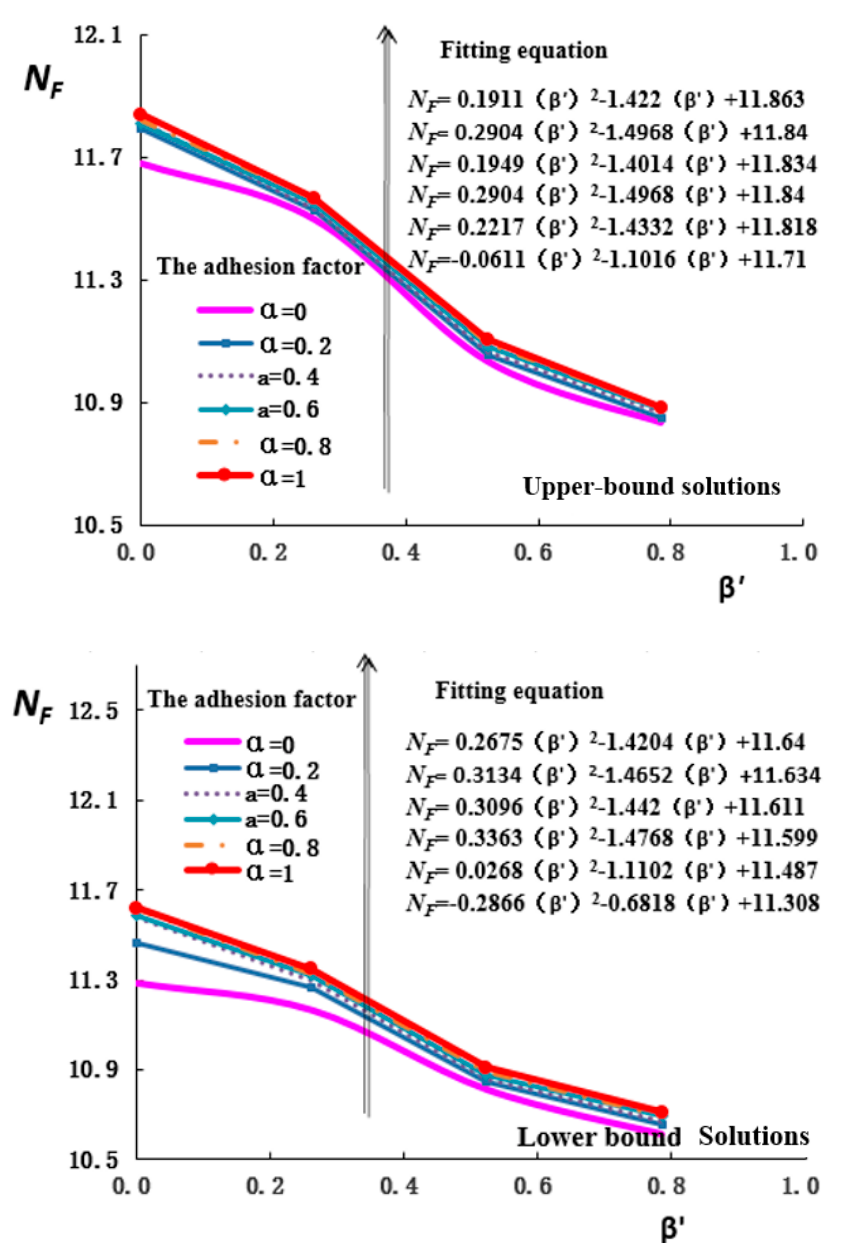
Figure 15. Relationship between the normalized ultimate lateral capacity ( N F ) of the four-wing pile and the direction of the lateral load ( β ’) when the wing-to-diameter ratio D e / B w = 3. ( Top ) upper- bound and ( Bottom ) lower-bound solutions from limit analysis with different pile–soil interaction coefficients (adhesion factors). Despite the different pile–soil interaction coefficients, the changing trends of the fitted curves in Figure 15 are identical. When the soil loading interaction coefficient was greater than 0.4, the range of the plastic zone of the soil in Figure 14 no longer increased. By setting the pile–soil interaction coefficient to 0.4, D e /B w was 3. The influence of the lateral-load direction on the shear plastic zone of the soil around the four-wing pile according to the upper-bound solution of the limit analysis is shown in Figure